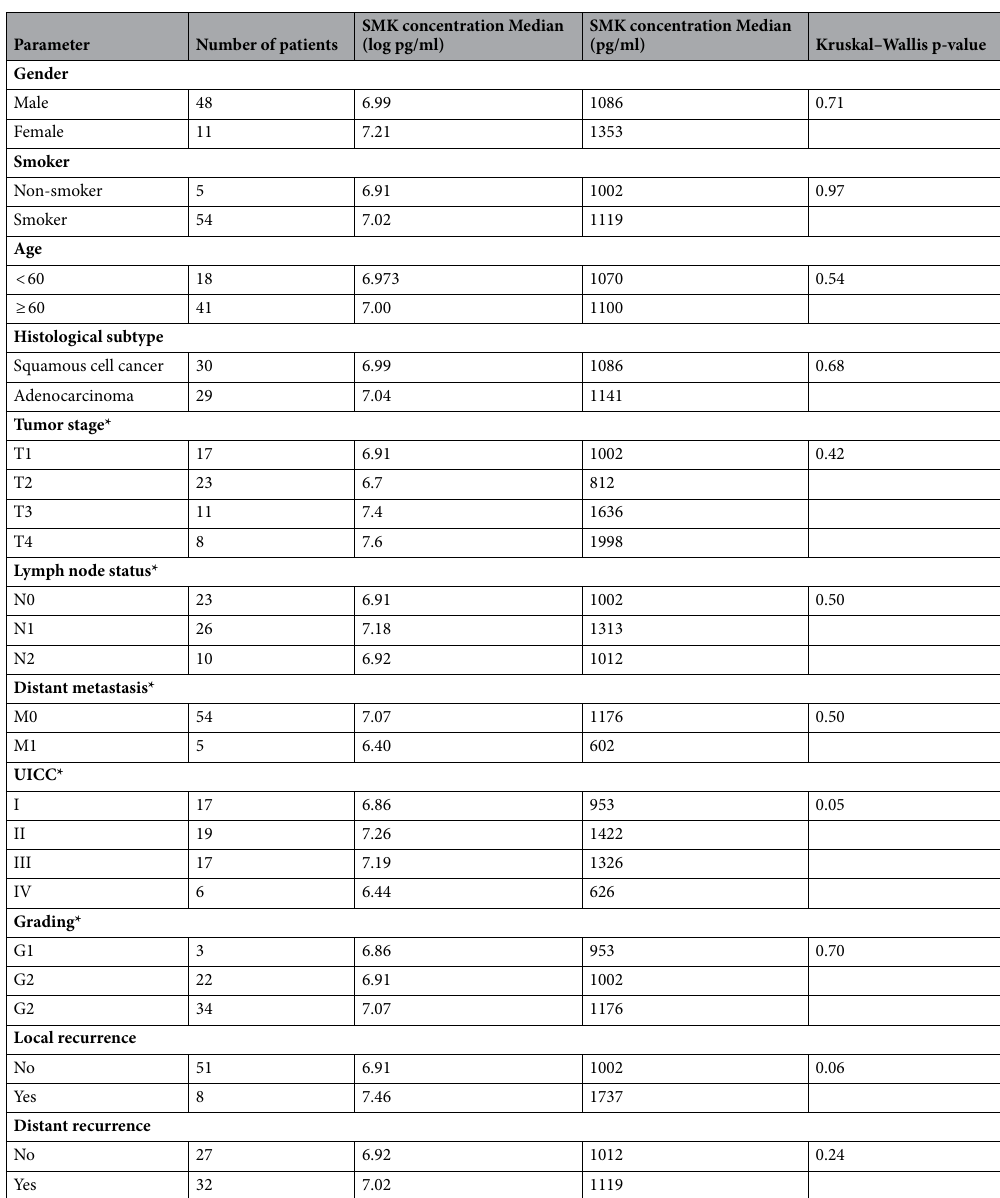
Table 1. Correlation of clinicopathological parameters with S-MK concentration. S-MK serum-midkine, UICC Union for International Cancer Control. *Pathological evaluation according to the guidelines of the Union for International Cancer Control